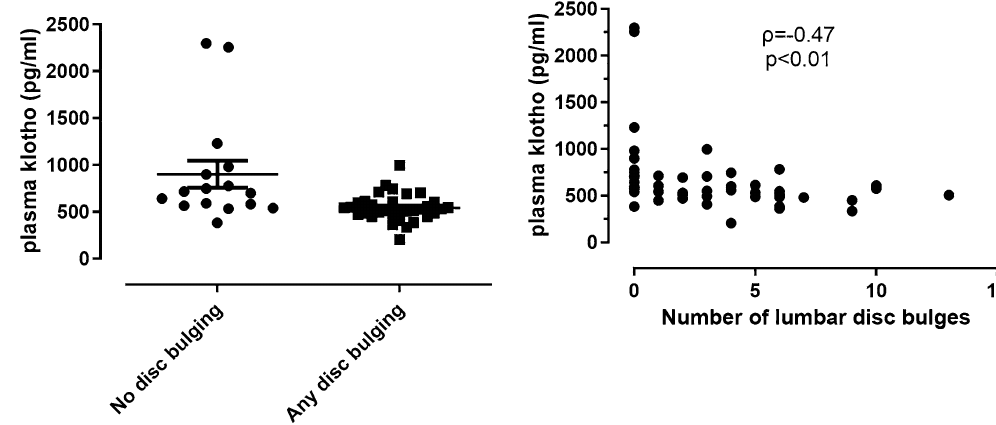
Figure 4. The relationship between plasma klotho levels and lumbar disc